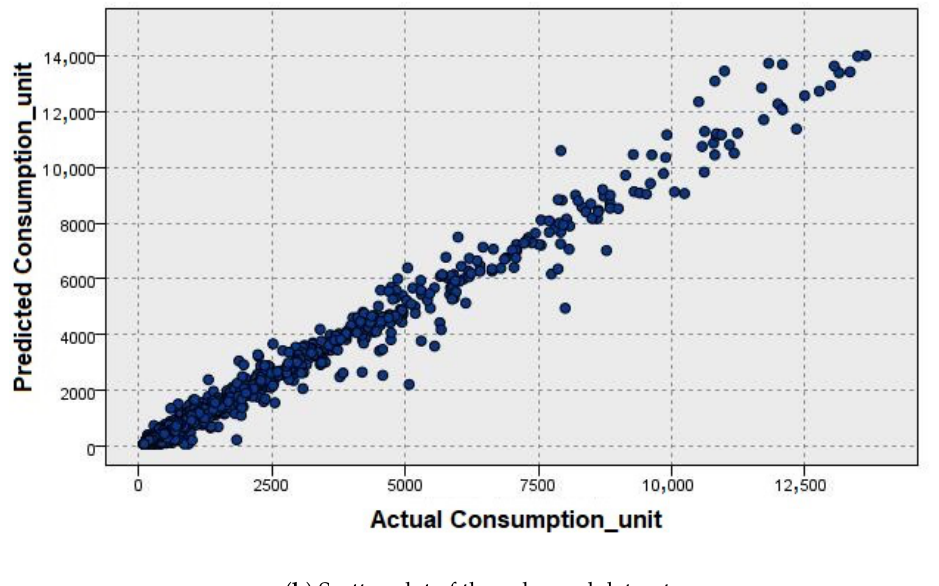
Figure 14. Scatter plots showing the relationship between the actual and predicted power consump- tion values using the